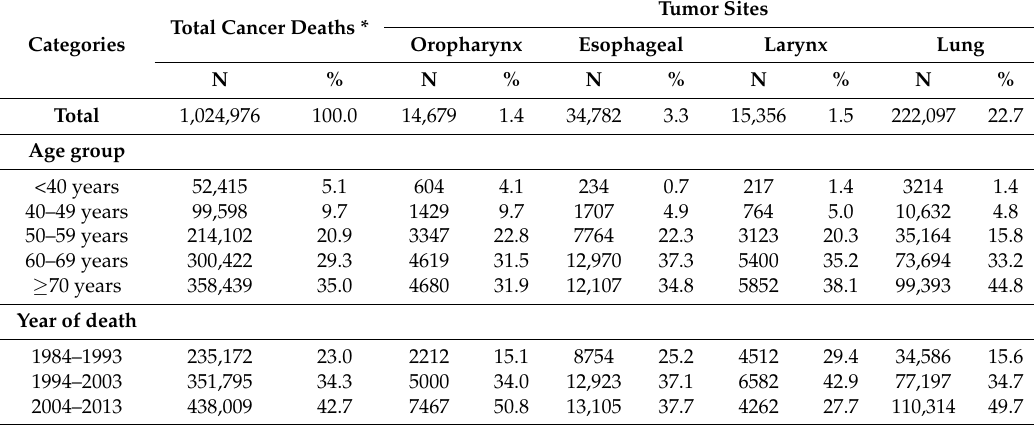
Table 1. Baseline characteristics of overall and smoking-related cancer deaths during the study period (1984–2013) in Korean